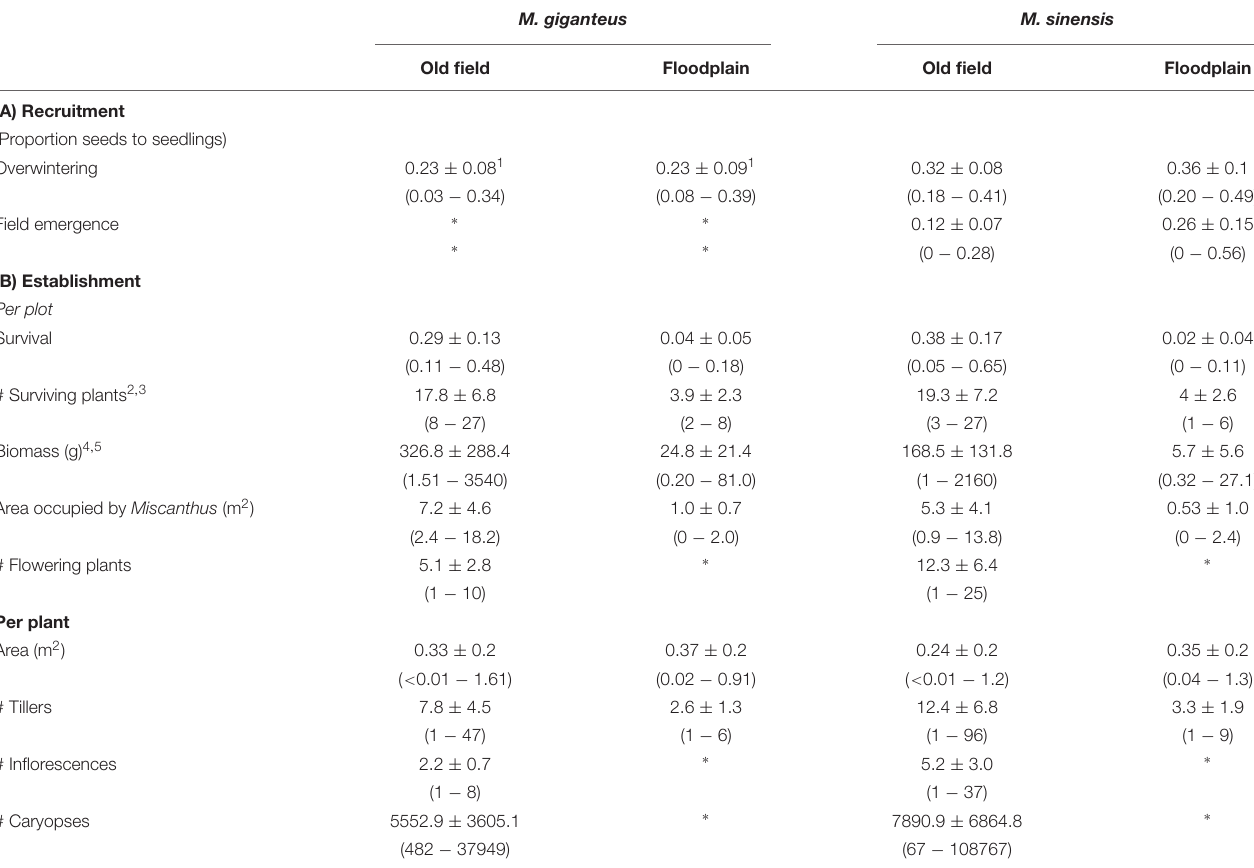
TABLE 1 | Miscanthus recruitment and establishment: Mean ± SD, as well as the range (in parentheses, minimum–maximum) of measurements in old field and floodplain forest